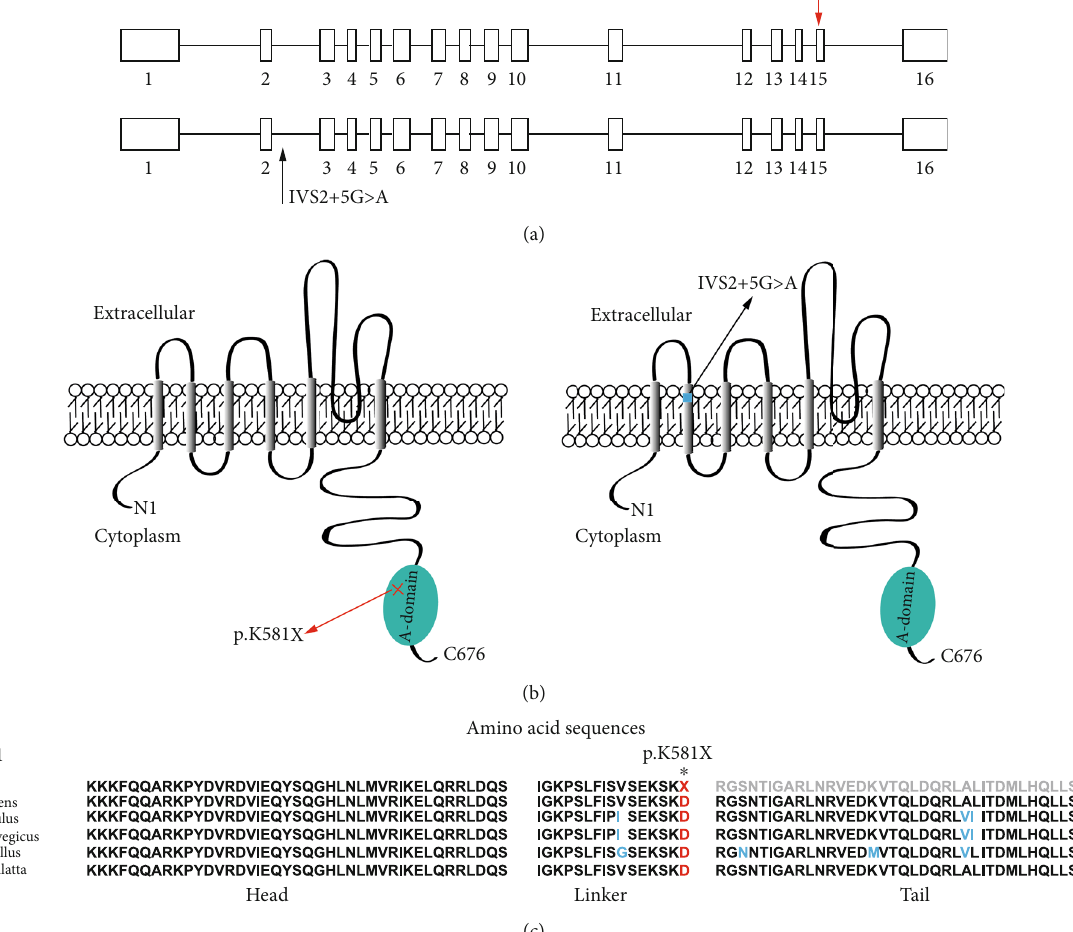
Figure 5: Molecular basis for the case of JLNS is detailed at gene and protein levels and evolutionary conservation of amino acids in A- domain a ff ected by the nonsense mutation. (a) Schematic diagram of 16 exons and 15 introns encoded by biallelic KCNQ1 genes ( KCNQ1 ; NM 000218.3). Two variants were indicated by arrows. Novel mutation is shown in red and known mutation is shown in black. Rectangle: exon. Line: intron. (b) Schematic diagram of α -subunit of IKS encoded by biallelic KCNQ1 genes ( KCNQ1 ; NM_000218.3) with pathogenic mutations of p.K581X (red cross) or IVS2+5G > A (blue rectangle). Six transmembrane segments (S1-S6) are indicated by gray columns and the pore-loop is located between S5 and S6. Green oval: A-domain. Red arrow: novel mutation. Black arrow: previously- reported mutation. (c) Evolutionary conservation of A-domain (head, linker, and tail). Mutated site is indicated by asterisk. Gray residues cannot be translated. Di ff erent residues were indicated in